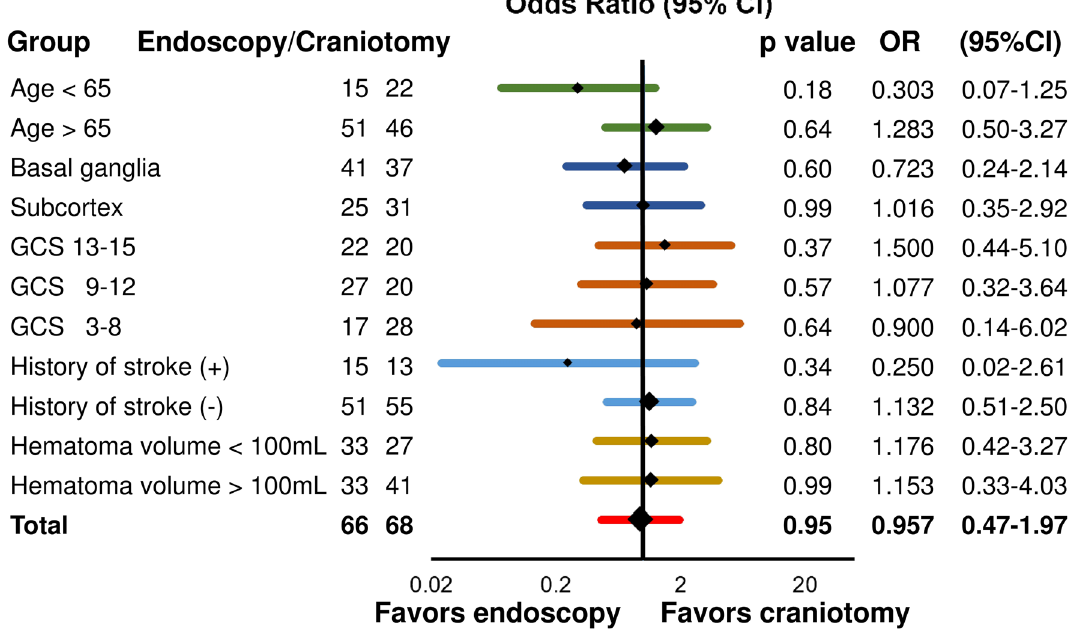
Figure 3. Shift towards the favorable outcome (modified Rankin Scale score 0–3) at 6 months adjusted for age, hematoma location, Glasgow Coma Scale (GCS) score severity on admission, the history of stroke, and the hematoma volume. The p -value, odds ratio (OR), and the 95% confidence interval (CI) were calculated using Fisher’s exact other complications were not statistically different between the two groups ( p = 0.22, 0.29, 0.99, 0.75, and 0.37, respectively) (Table 2). The endoscopic procedure was not related to the favorable outcome. (Fisher’s exact test; p = 0.95, unadjusted odds ratio 0.957; 95% CI 0.465–1.971) (Figs. 2 and 3). After adjusting for the stratified categorical variables extracted from the univariate analysis (age, hematoma location, use of antithrombotic drugs, GCS score severity, history of stroke, and the hematoma volume; described in detail later with Table 4), the endoscopic procedure was not associated with the favorable outcome (Fig. 3). The cut-off of age was 65, according to the retirement age in Japan. That of hematoma volume was 100 mL based on the clinical experience. GCS score was divided into 3–8, 9–12, and 13–15 38 . The GCS score on day seven was found correlated with the systolic blood pressure, GCS score on admis- sion, and the preoperative hematoma volume (Spearman’s rank correlation coefficient, r = 0.252; p = 0.004; r = 0.716, p < 0.001; r = − 0.385, p < 0.001, respectively). Endoscopic procedure and hematoma at basal ganglia